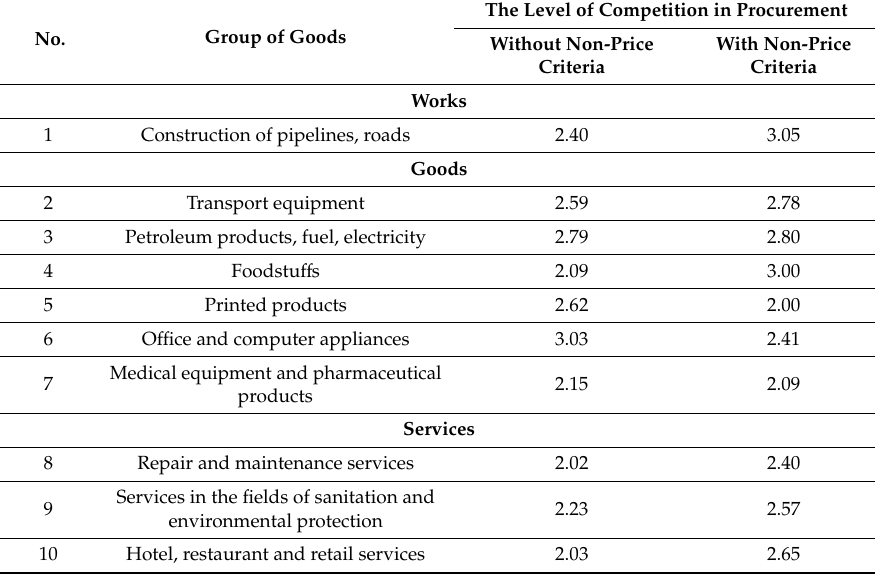
Table 2. Level of competition for selected items, depending on the use of non-price criteria. The Level of Competition in Procurement Group of Goods Without Non-Price